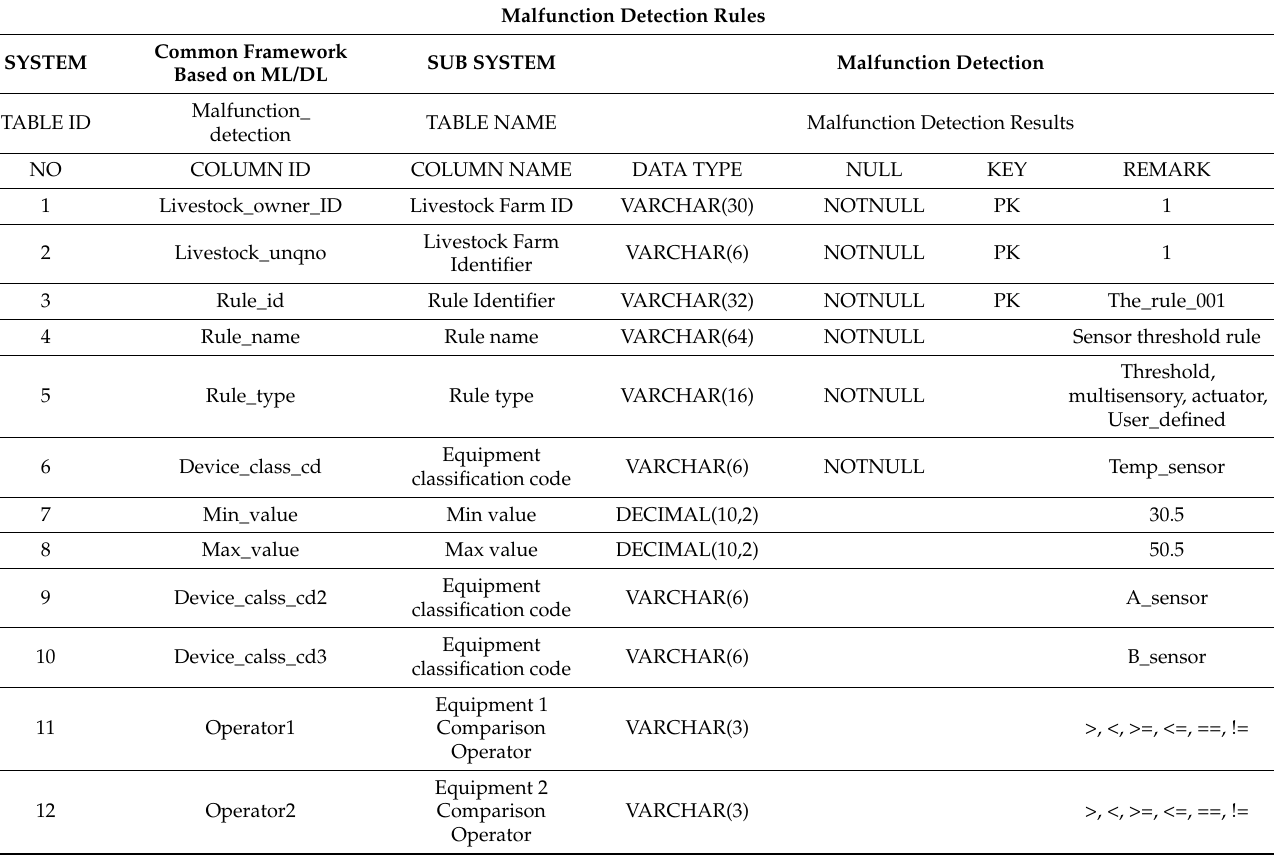
Table 3. Database showing the rules for malfunction